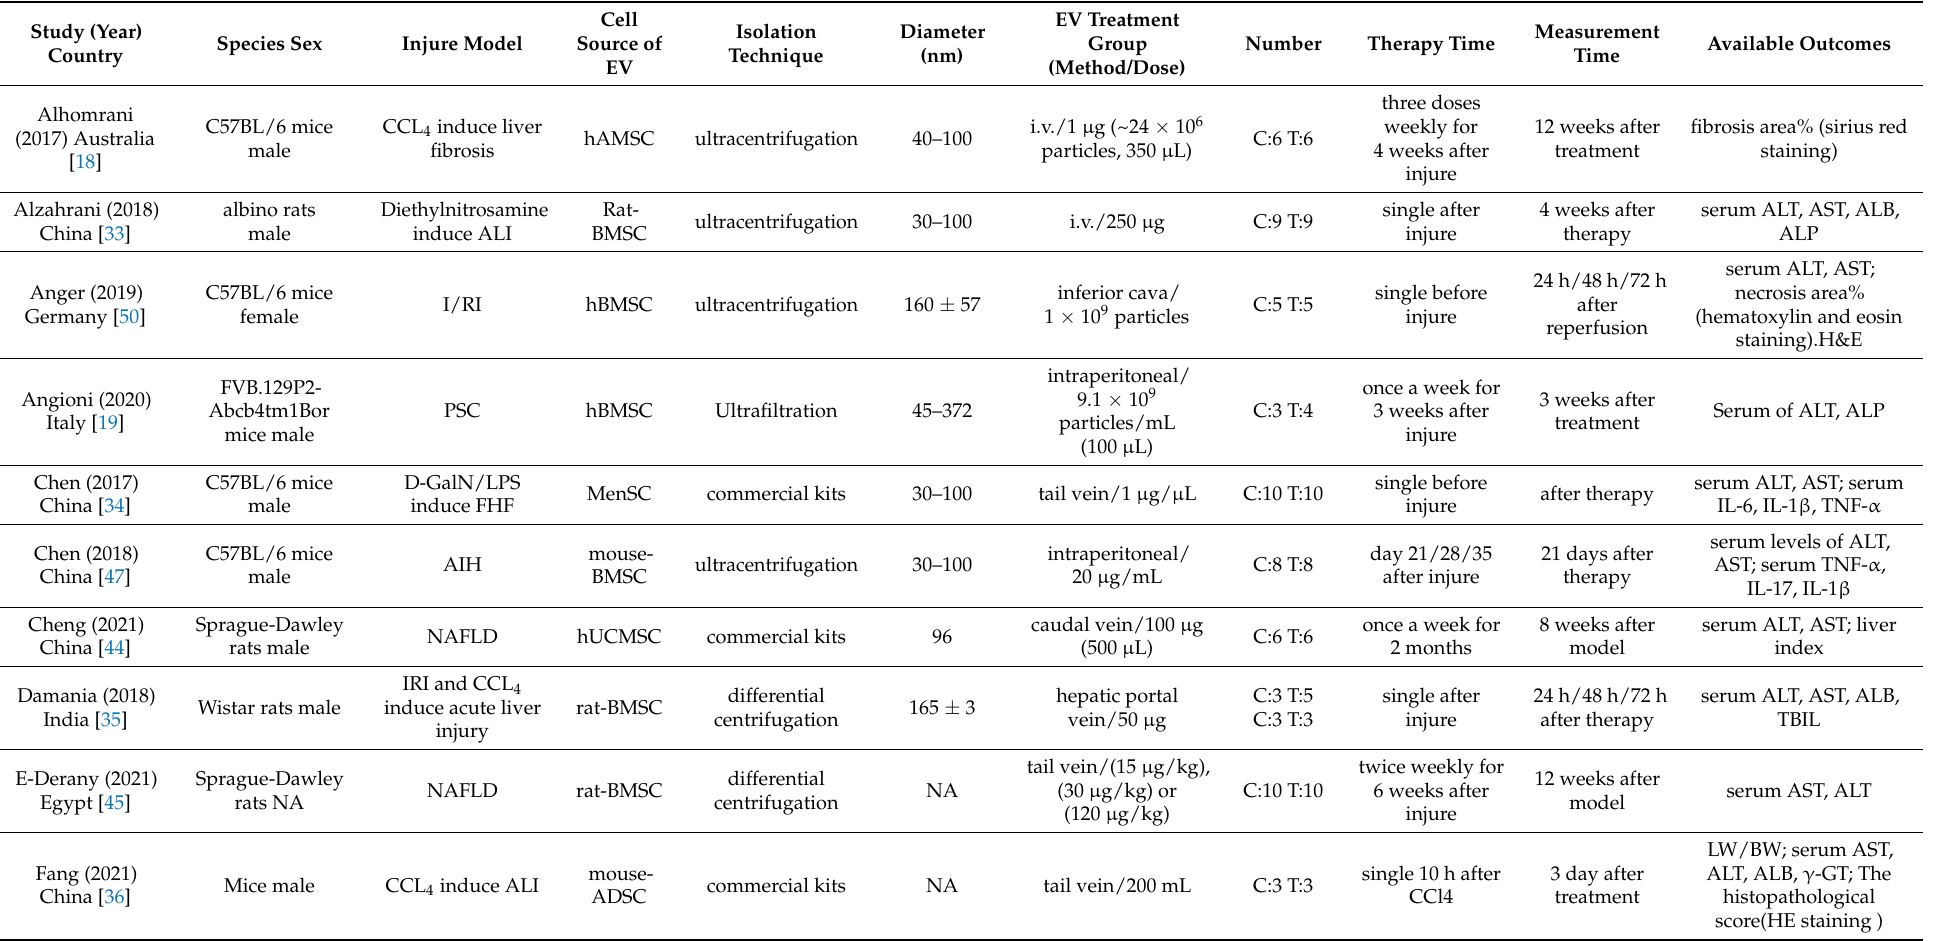
Table 1. Character of included